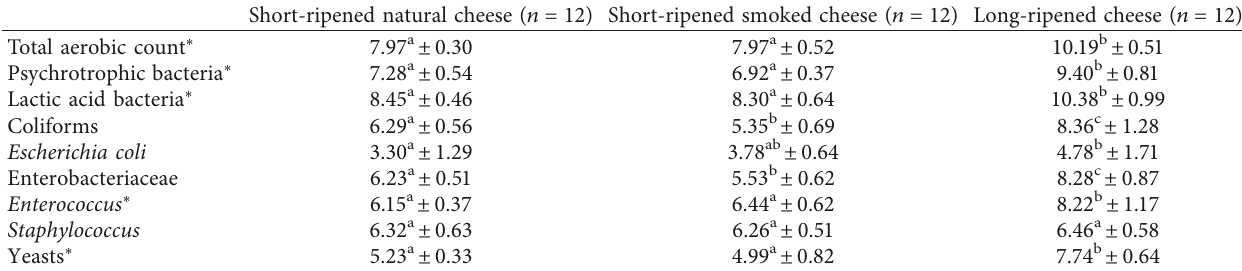
Table 1: Microbiological counts (log cfu/g) of different microbial groups for three types of cheese (mean ± SD).